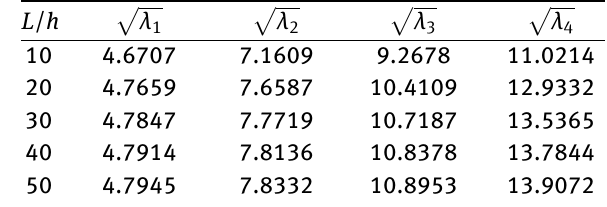
(︁ √ )︁ for CC case for different λ